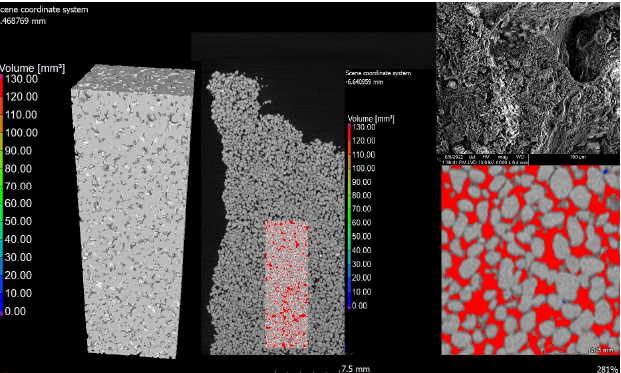
Figure 14. Computer tomography—an image and a three-dimensional cross-section through a sample of a traditional sand-lime brick with quartz sand (laboratory production).